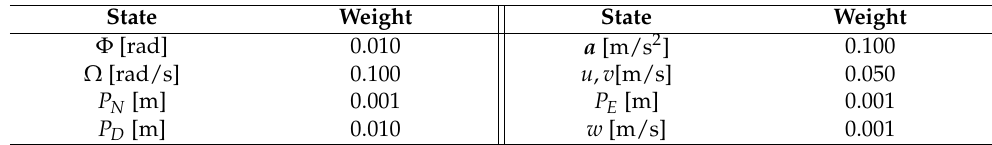
Table 6. Process covariance